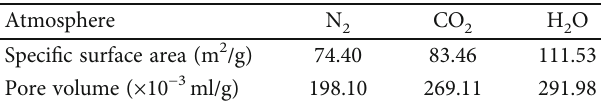
Table 5: The speci fi c surface area and pore volume of solid residues in di ff erent